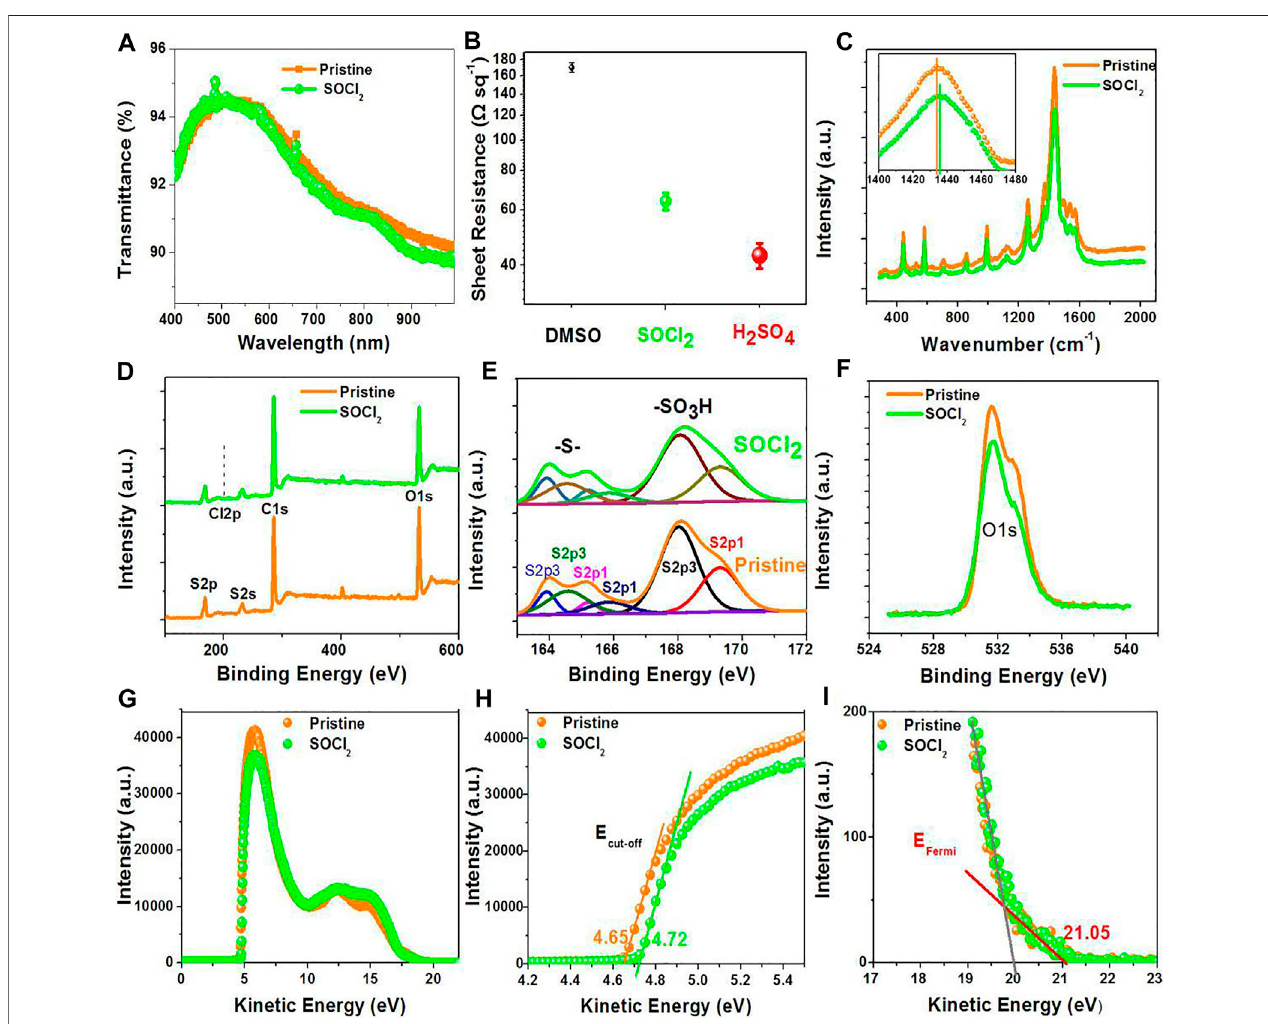
FIGURE 2 | (A) Transmittance spectra of the pristine and SOCl 2 -treated PEDOT:PSS fi lms. (B) Sheet resistance of the PEDOT:PSS fi lms with 6 vol.% DMSO treatment, > 99 wt.% SOCl 2 treatment, and 98 wt.% H 2 SO 4 treatment. (C) Raman, (D) Total XPS, (E) S2p XPS, (F) C1s XPS, (G) UPS, (H) E cutoff region, and (I) E Fermi region spectra of the PEDOT:PSS fi